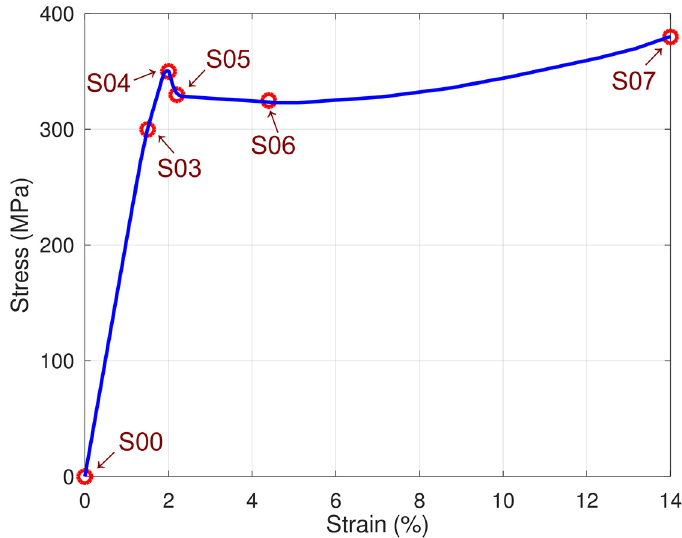
Figure 2. The stress–strain curve for the examined SS400 specimens.